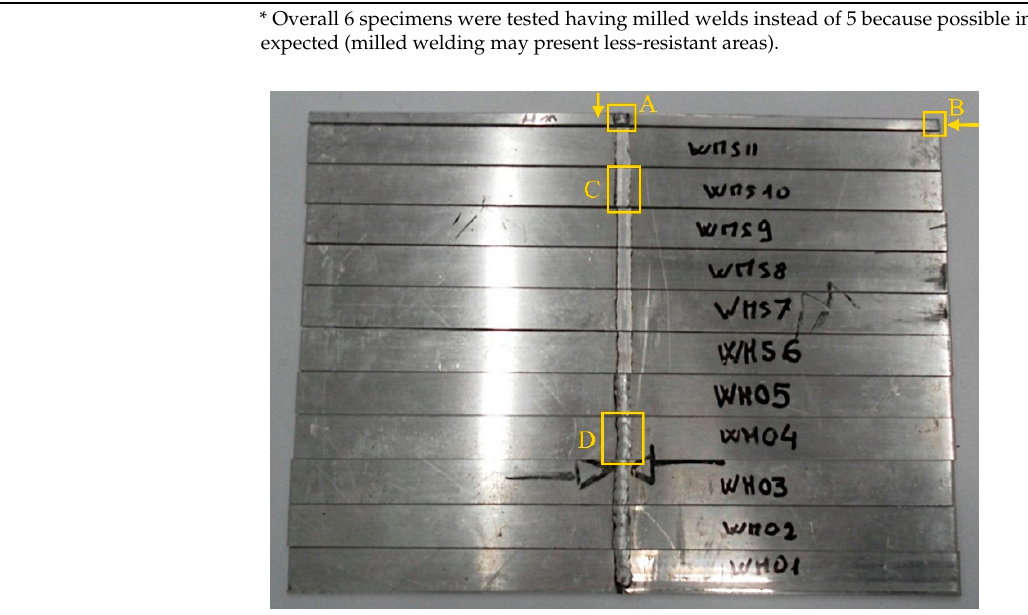
Figure 3. Sheets after waterjet cutting and MIG welding. The welded sheets were cut to obtain tensile test specimens and samples for microstructural observation and micro-hardness measures. A: Sample for weld observation and micro-hardness; the arrow indicates the side of observation. B: Sample for edge observation and micro-hardness; the arrow indicates the side of observation. C: Milled weld. D: Protruding weld. Table 3. Specification for specimen studied/tested.